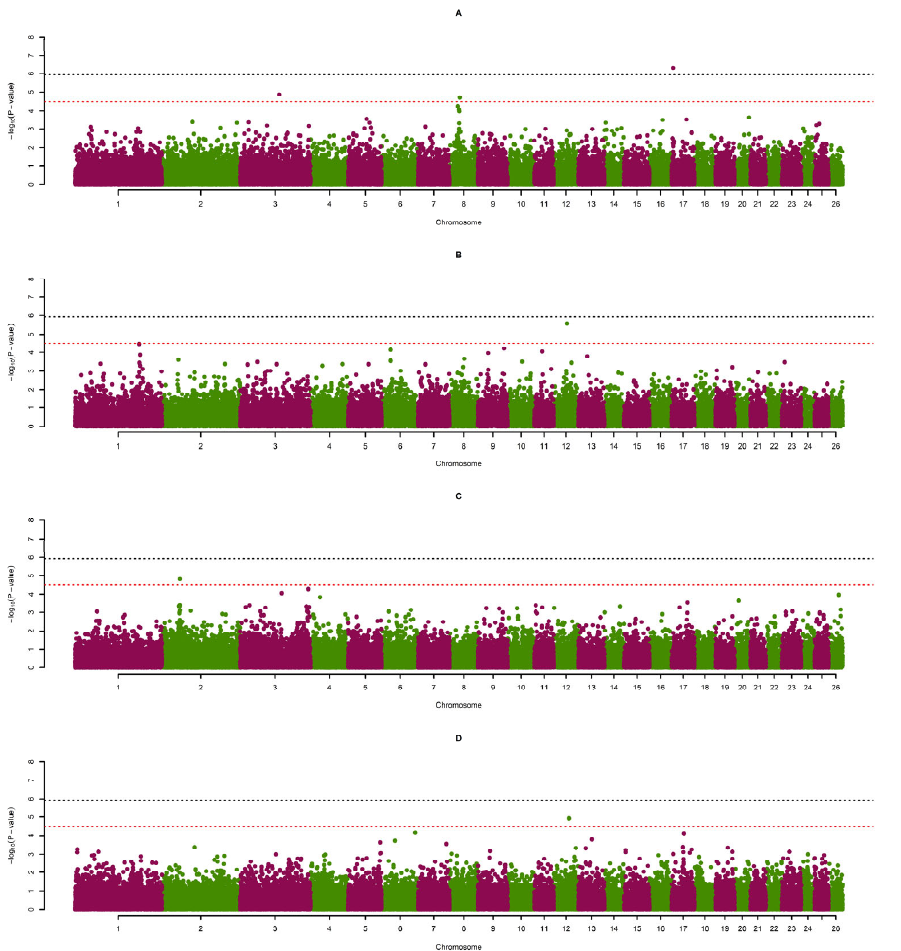
Figure 1. Manhattan plots of four wool traits. A black dashed line indicates genome-wide significance and a red dashed line indicates chromosome-wide significance. Fibre diameter at 8 months of age (FD) ( A ), staple length at 8 months of age (SL) ( B ), yearling fibre diameter (YFD) ( C ) and yearling staple length (YSL) ( D ) are the depicted traits of interest.